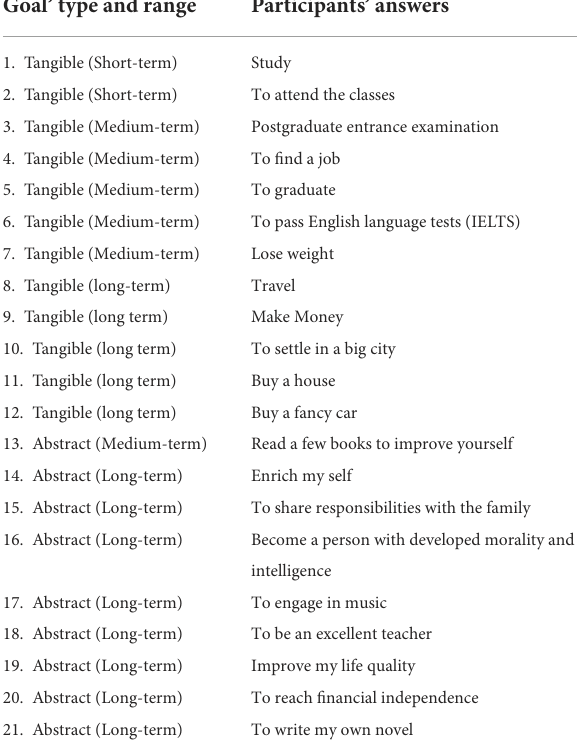
TABLE 2 Goals type and range examples. Goal’ type and